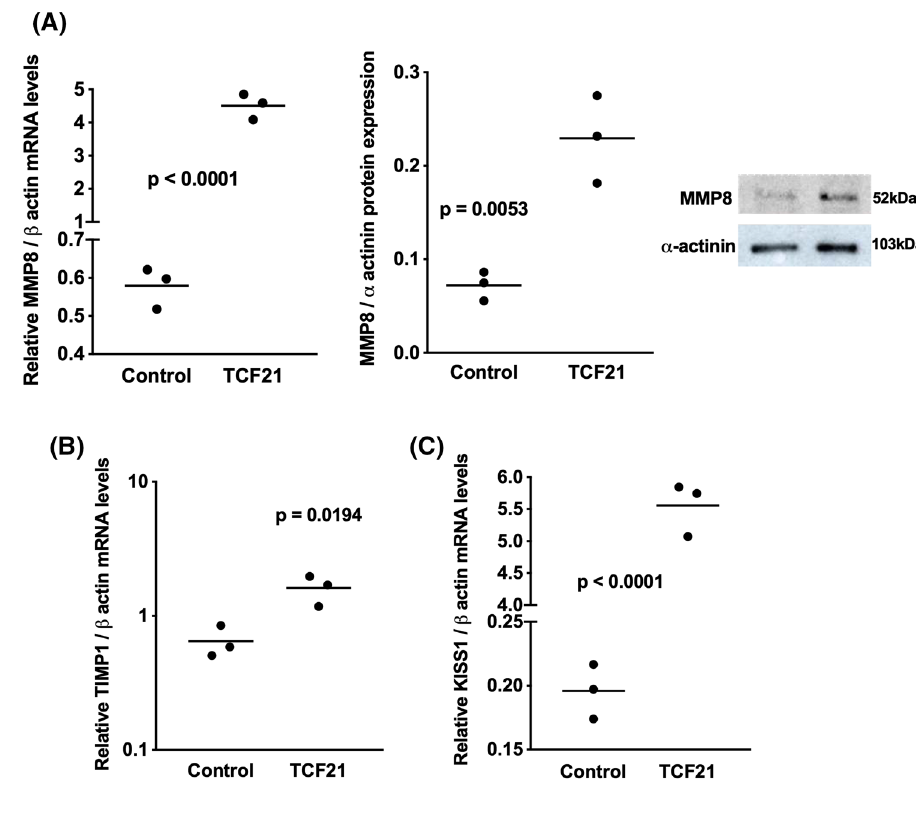
Fig. 5 TCF21 increased the expression of anti-invasive effectors in ACC cells. A Rela- tive mRNA level and protein expression of metalloprotein- ase 8 (MMP-8) and representa- tive immunoblot; B Relative mRNA level of metallopro- teinase inhibitor 1 ( TIMP-1 ); C Relative mRNA level of tumor metastasis suppressor 1 KISS-1 , in H295R/TCF21 cells and respective controls. The experiments were performed in triplicate and repeated three times. The results were expressed as the mean ± SD. Statistical significance was assessed by unpaired t